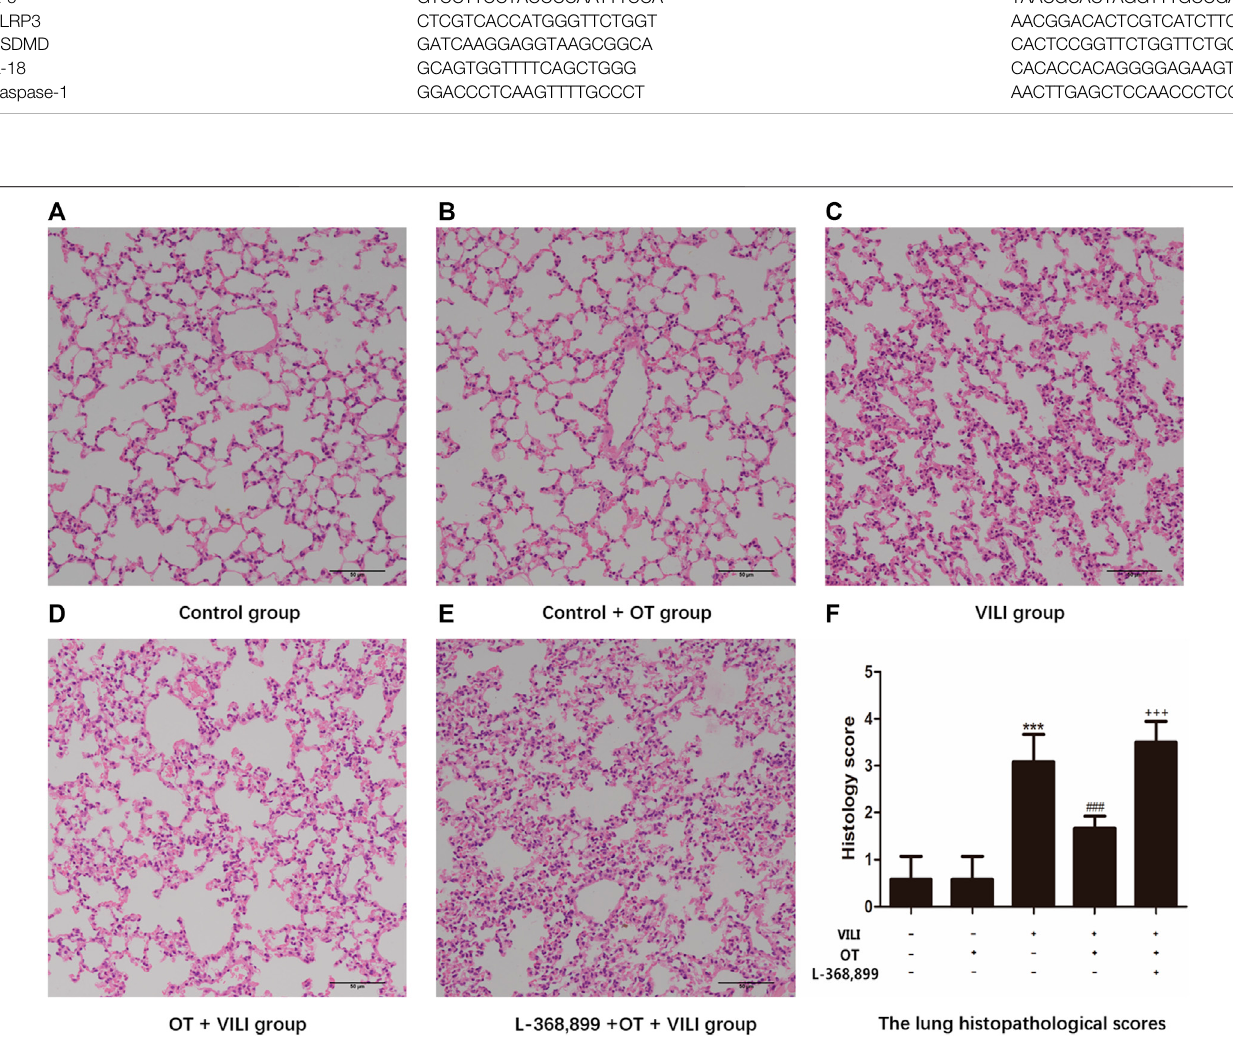
FIGURE 2 | Oxytocin attenuates ventilation-induced lung injury-related pathological changes in the mouse model. Pathological changes in mouse lung tissues are observedusingHEstainingbylightmicroscopymagni fi cation × 200. (A) Controlgroup. (B) Control+OTgroup. (C) VILIgroup. (D) OT+VILIgroup. (E) L-368,899+OT+ VILIgroup. (F) Thelunghistopathologicalscoresarepresented.Thedataarepresentedasthemeans ± SD( n (cid:2) 5).*** p < 0.001comparedwiththeControlandControl+ OT groups, ### p < 0.001 compared with the VILI group, and +++ p < 0.001 compared with the OT + VILI group. OT, oxytocin; SD, standard deviation; VILI, ventilation-induced lung